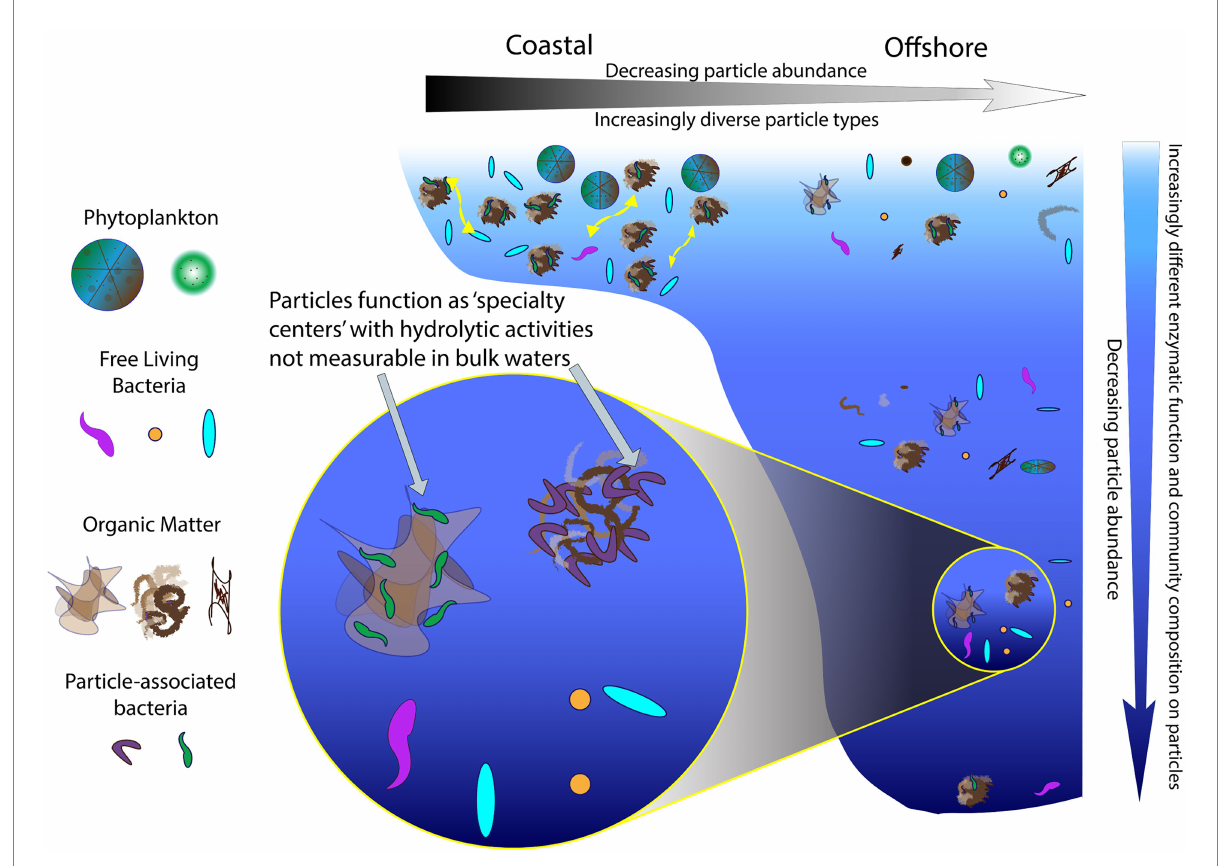
FIGURE 8 A continuum of particles and enzyme activities in the ocean. Particles serve as ‘specialty centers’ of enzymatic activities, showing an increase in functional capabilities that differs with location (coastal vs. offshore) and with depth in the